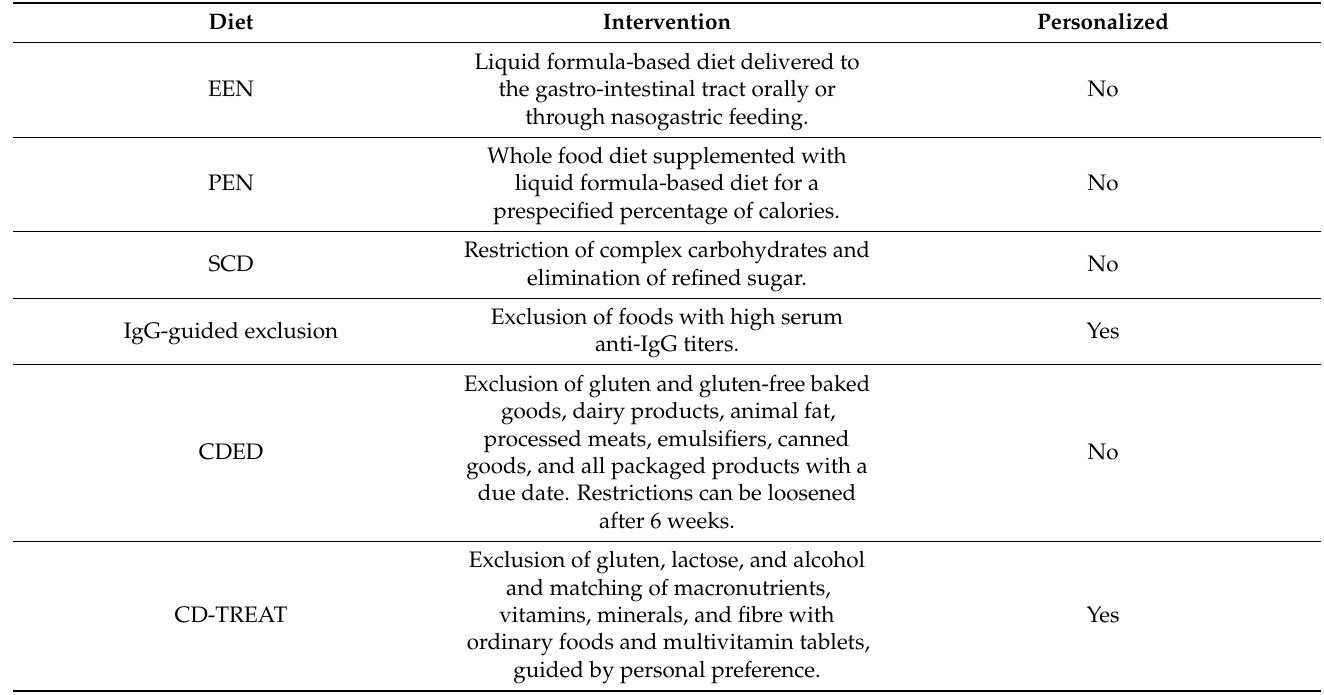
Table 1. Short description of dietary